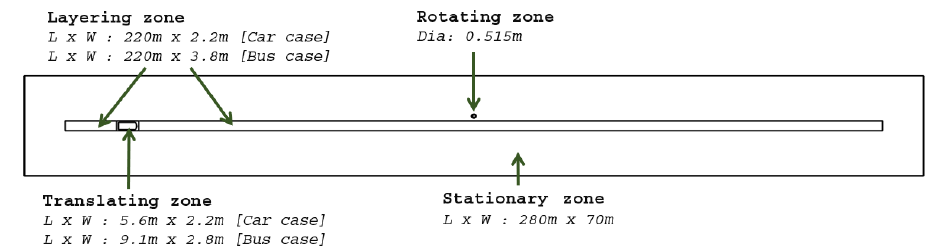
Figure 4. Windshield arc length, θ .